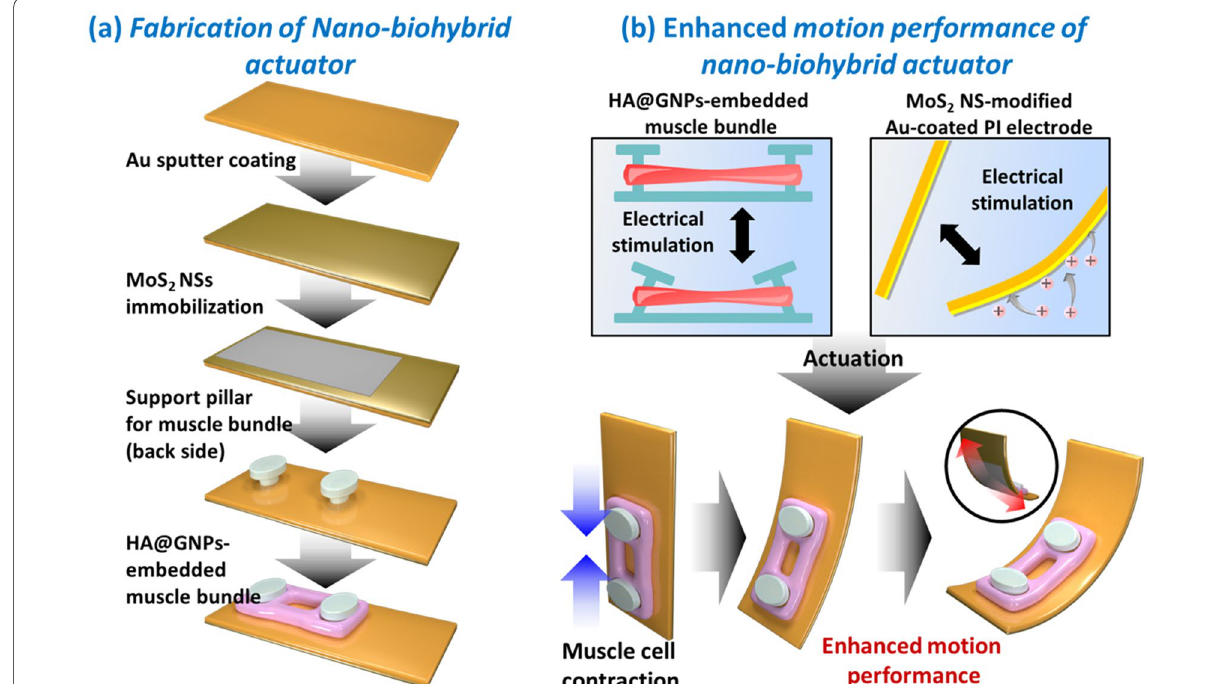
Fig. 1 Schematic diagram of electroactive nano‑biohybrid actuator fabrication and its actuation mechanism. a fabrication of the electroative nano‑biohybrid actuator by using HA@GNPs‑embedded muscle bundle and MoS 2 NSs based acutator. b preparation of HA@GNPs‑embedded muscle bundle and the motion performance of